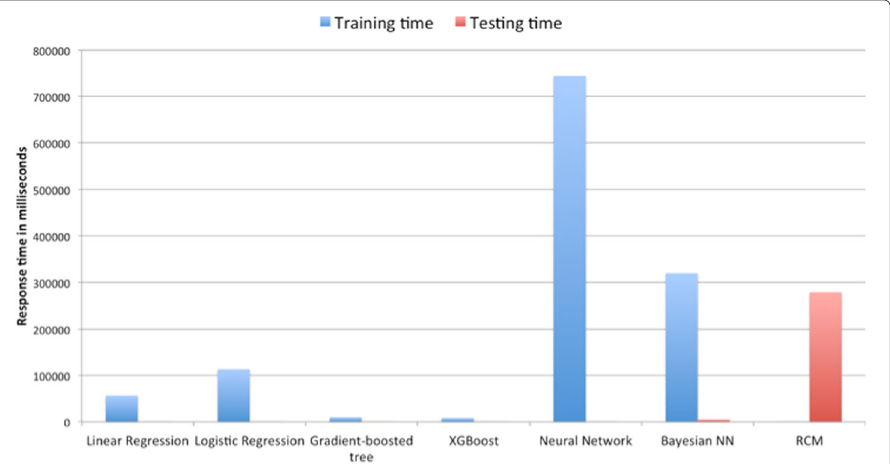
Fig. 5 Response time in milliseconds for training and testing the